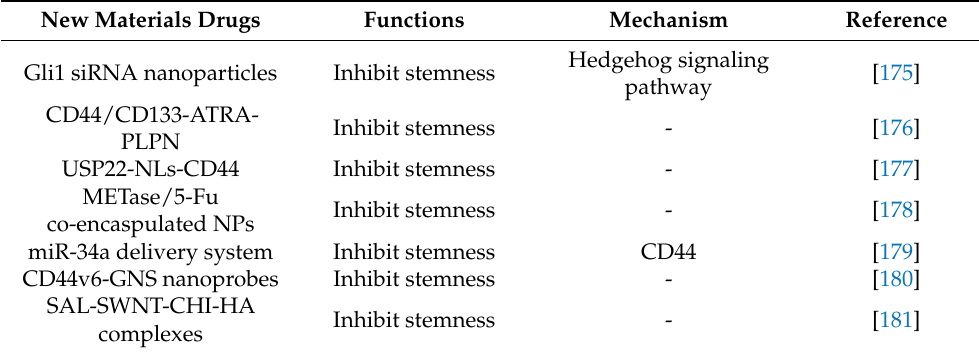
Table 7. New materials for GC treatment by inhibiting its